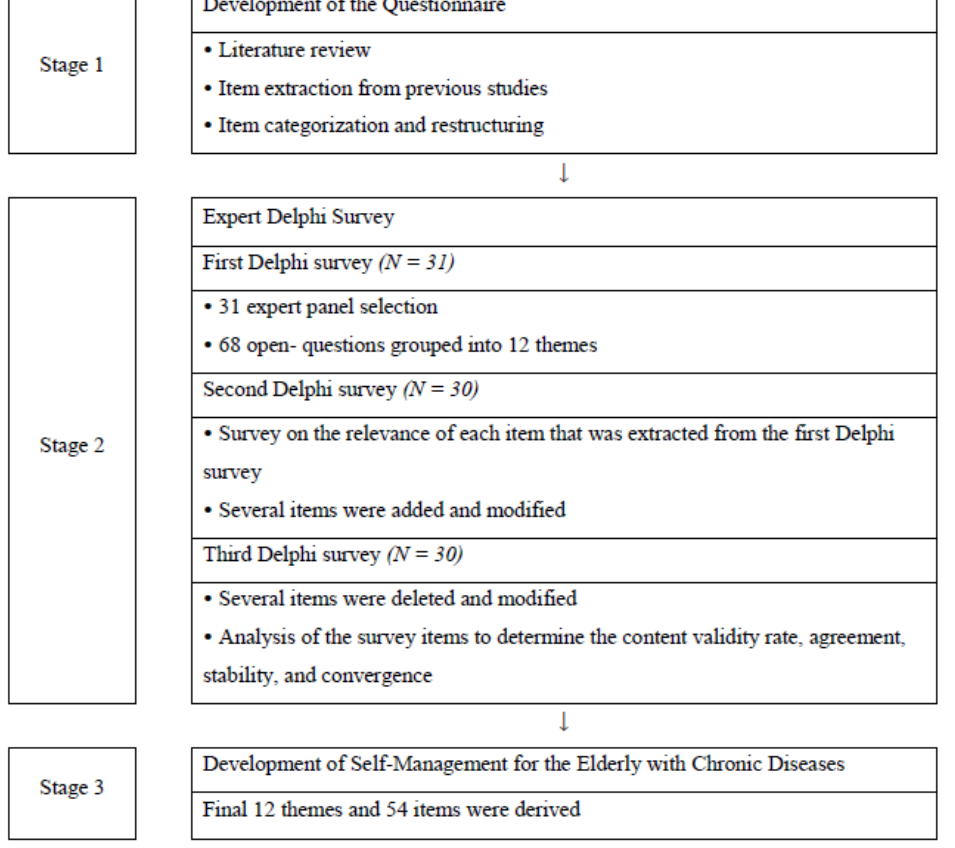
Figure 1. Overall Delphi survey research process consisting of three stages.